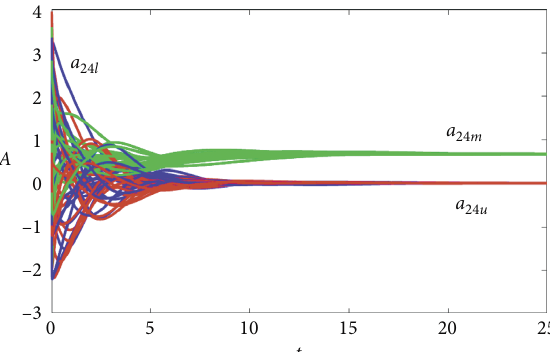
Figure 5: Transient behaviors of of fuzzy bridge regression coefficient A points in Example